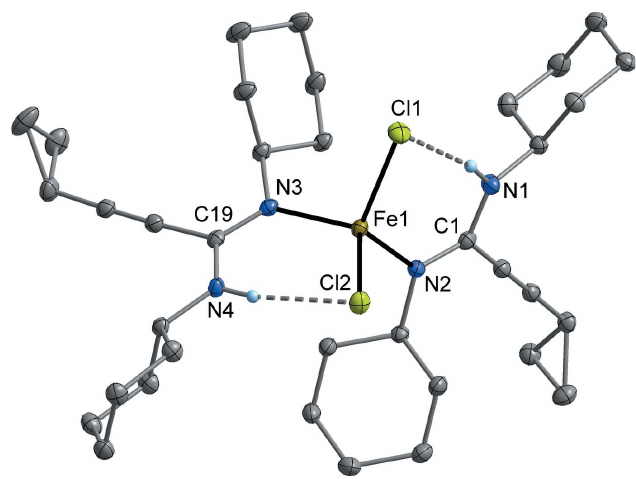
Figure 4 Molecular structure of 5 in the crystal. Displacement ellipsoids are drawn at the 50% level, C-bound H atoms omitted for clarity.